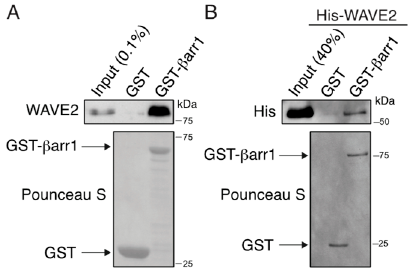
Figure 6. WAVE2 interacts directly with β -arrestin1. ( A ) Binding of β arr1 to endogenously expressed WAVE2 in HeLa cells. Equimolar amounts (~1 µ M) of immobilized GST- β arr1 or GST on glutathione-sepharose resin were incubated HeLa cell lysates, and binding reactions were analyzed by immunoblotting. Ponceau S-stained blot shows GST and GST- β arr1 from the binding reaction. Input represents 0.1% of lysate used in the binding reaction. ( B ) Binding of purified WAVE2 to β arr1. Equimolar amounts (~1 µ M) of GST- β arr1 or GST immobilized on glutathione-sepharose resin were incubated with HIS-WAVE2 (0.5 µ M), and pulldown and input samples were analyzed by immunoblotting. Ponceau S-stained blot shows GST and GST- β arr1 from the binding reaction. Input represents 40% of HIS-WAVE2 used in the binding reaction. Data are representative of 3 independent